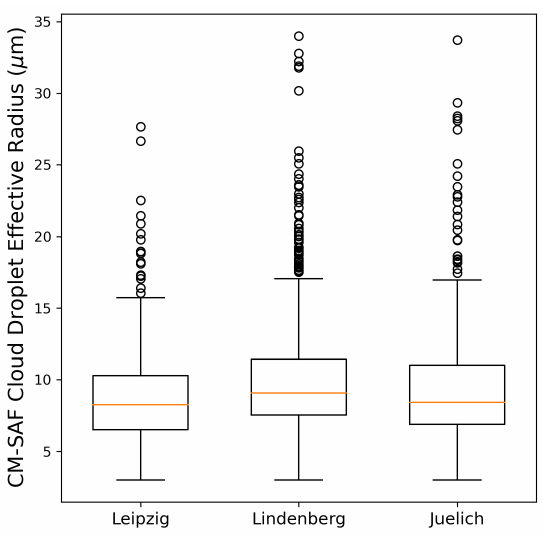
Figure A1. Droplet effective radius derived from CM SAF CLAAS-2 for test data for the study